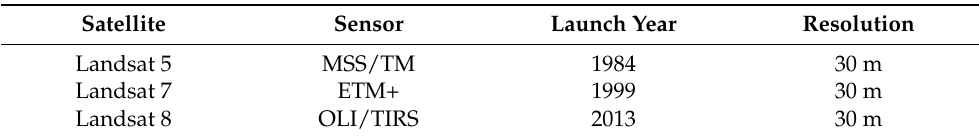
Table 1. Characteristics of the Landsat sensors used in the study. Satellite